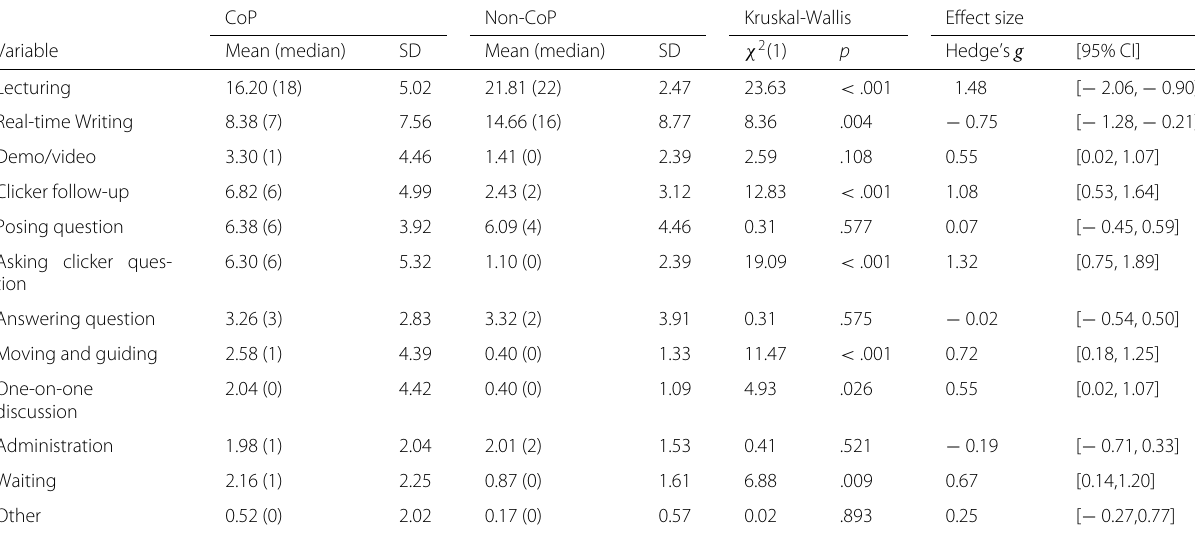
Table 3 Comparisons of central tendency and variation of the total counts of 2-min intervals where instructor behavior, as indicated by the original list of COPUS codes (from Smith et al. 2013), was observed by CoP ( n = 25) and non-CoP ( n = 35)